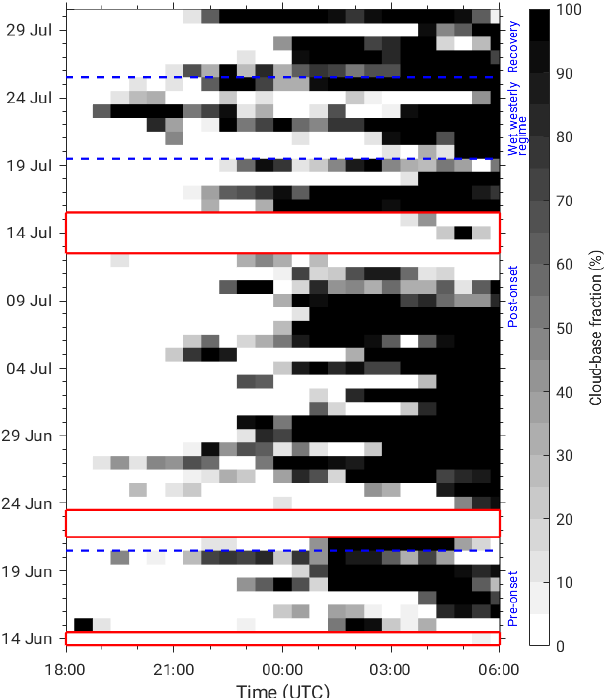
Figure 2. The cloud-base fraction for CBH detected between 0 and 500ma.g.l. measured at Savè in the period between 18:00 and 06:00UTC during the whole DACCIWA campaign. Red rectangles indicate six stratus-free nights. The periods of different synoptic phases (Knippertz et al., 2017) are denoted with blue dashed